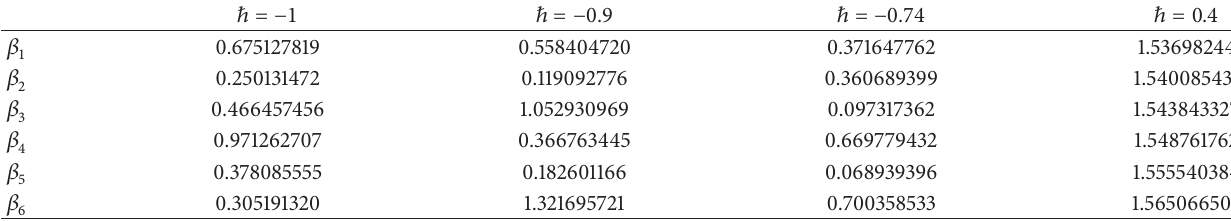
Table 1: Numerical values of 𝛽 𝑖 ’s for different values of ℎ in Example 1.